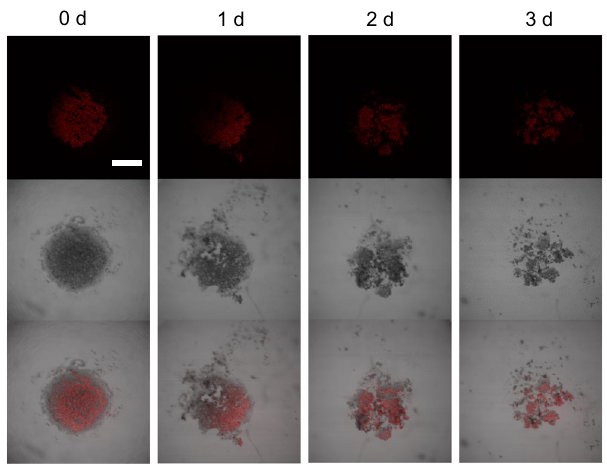
Fig. 6 Photocytotoxicity of compound 1 to MCF-7 cells 3D MCTS. The CLSM images of MCTS incubated with compound 1 (10 μ M) for 4 h (0 d) and then exposed to white-light irradiation (40 mW/cm 2 ) for 20 min each day (1 d, 2 d, 3 d). The experiment was repeated three times independently, with similar results. Scale bar: 400 μ